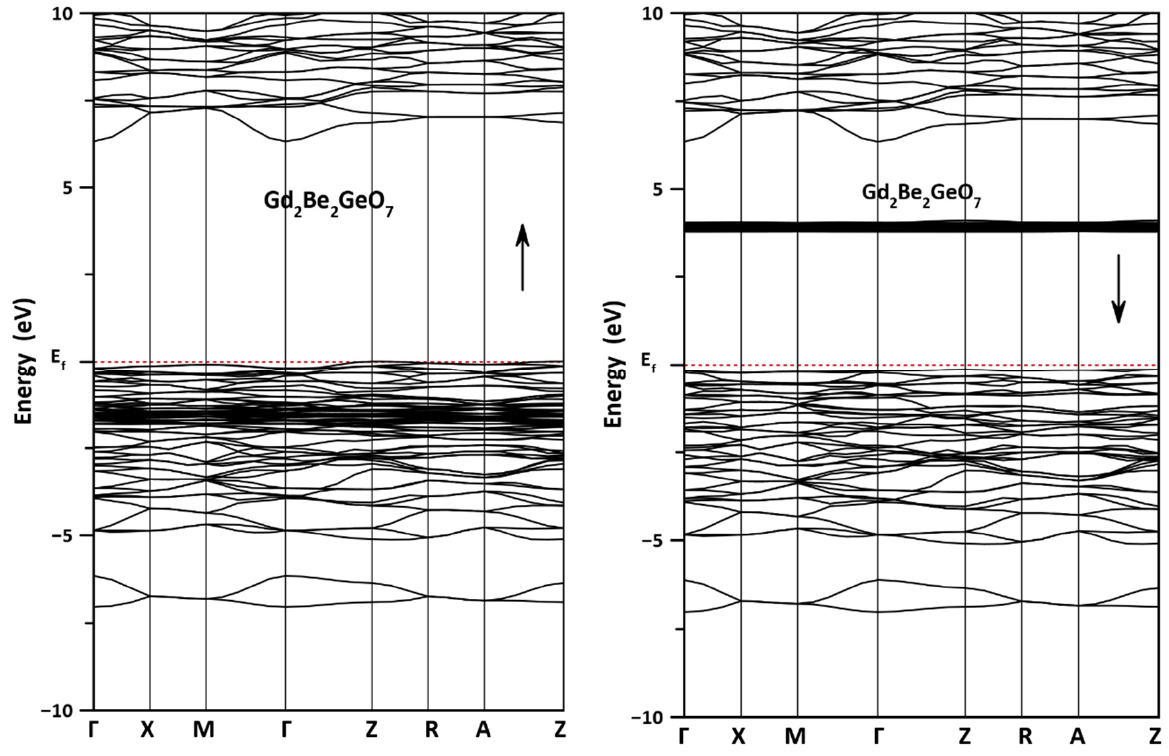
Figure 4. The spin-polarized electronic band structure for Gd 2 Be 2 GeO 7 compound in melilite tetragonal structure along with high symmetric directions with GGA-mBJ.